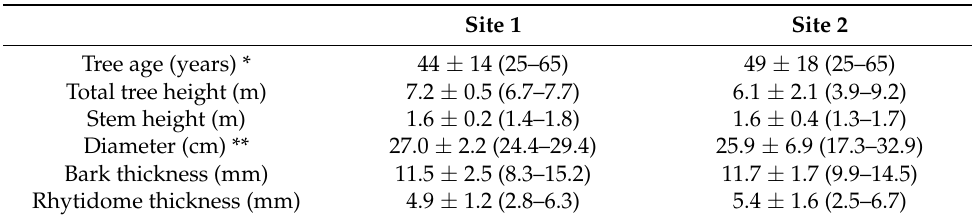
Table 1. Characteristics of the studied Quercus rotundifolia trees from two sites (mean and standard deviation of five trees, min and max in